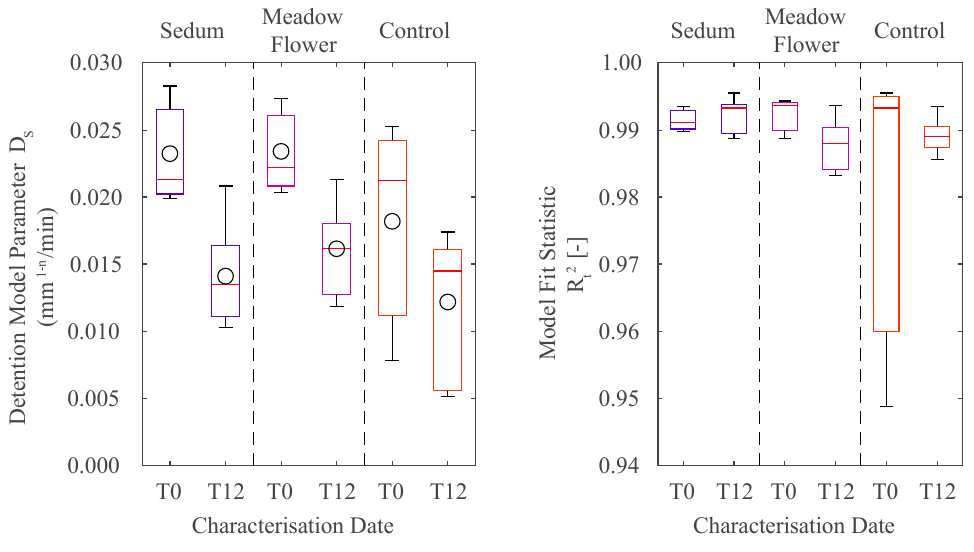
Figure 5. ( Left ) Optimized detention parameter D S for BBS 50 mm substrate microcosms at T0 and T12. ( Right ) Corresponding R 2 values for detention parameter D S